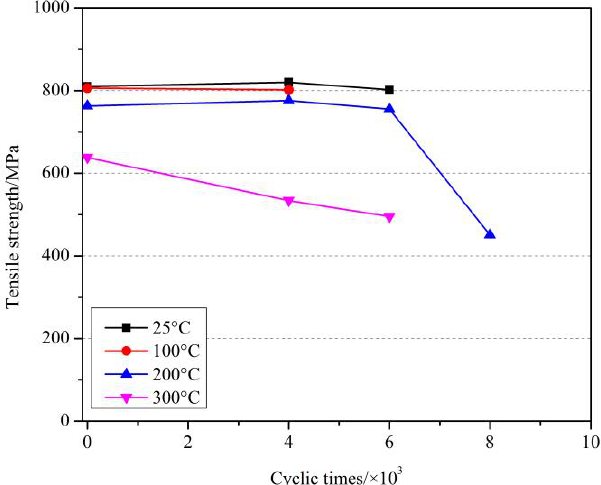
Figure 7. The effect of cyclic load on the tensile strength of GFRP bars after elevated temperatures with a holding time of 1 h.